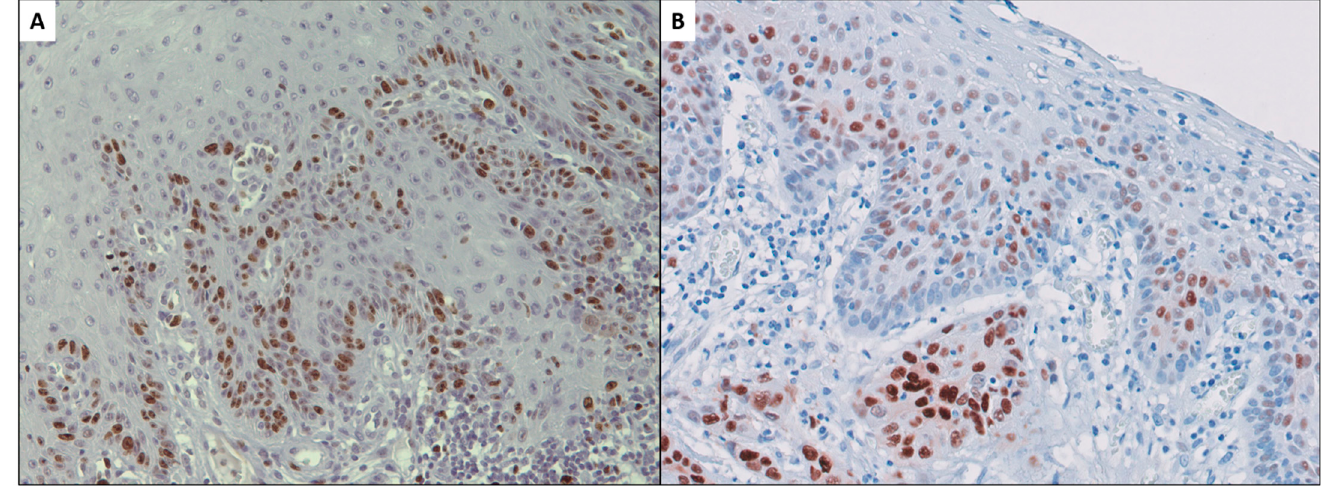
Figure 4. Ki-67 expression in oral squamous cell carcinoma in the earliest stages of invasion ( A ). Cyclin D1 proliferation-stimulating protein expression in early oral carcinoma and adjacent premalignant epithelium ( B ) [71,72].